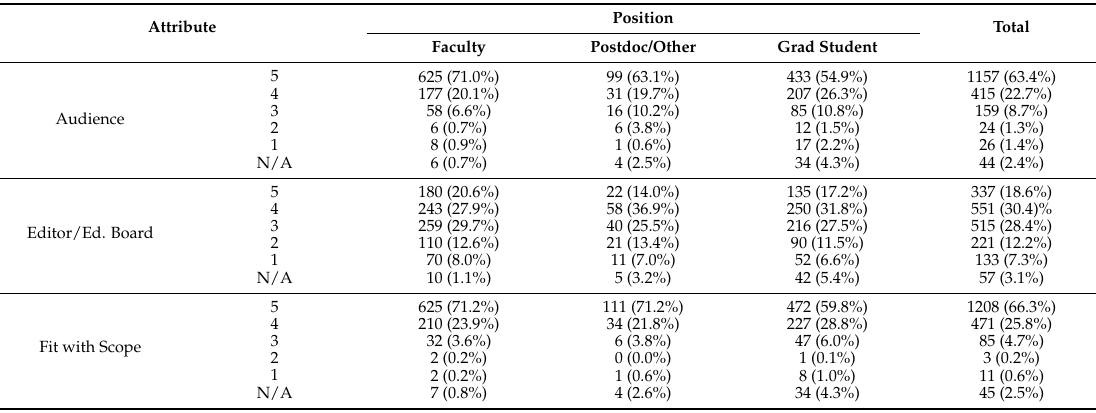
Table 6. Journal attribute importance: percentage by